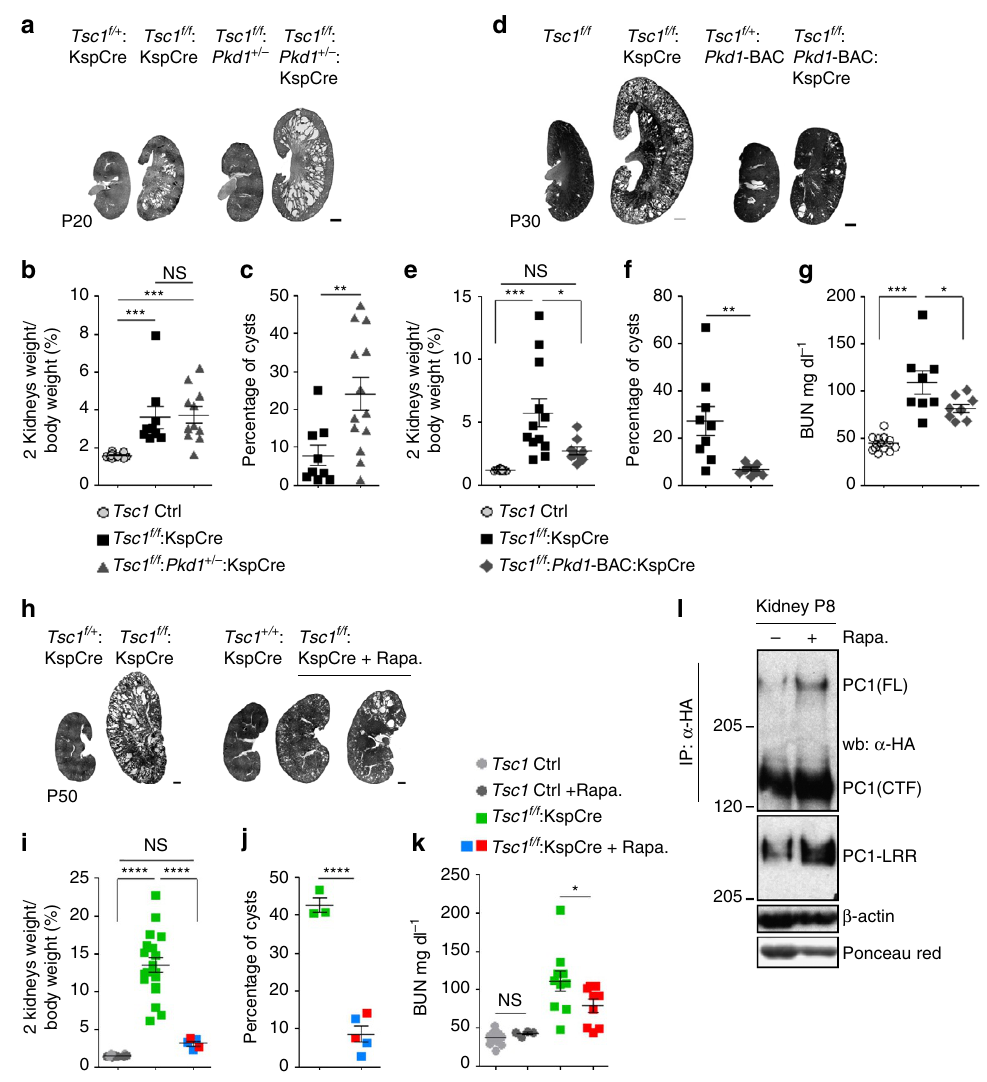
Figure 5 | Downregulation of PC-1 in Tsc1 mutant kidneys contributes to cyst formation. ( a ) H&E staining of kidney sections from Tsc1 f/f :KspCre , Tsc1 f/ f :Pkd1 þ /- :KspCre and control mice at P20. Scale bar, 1,000 m m. ( b ) Graph shows the two kidneys over body weight ratio at P20 in Tsc1 f/f :KspCre ( n ¼ 9) and Tsc1 f/f :Pkd1 þ /- :KspCre ( n ¼ 13) compared with controls ( n ¼ 18). Data are shown as mean ± s.e.m. ( c ) Graph shows the cystic index in Tsc1 f/f :KspCre ( n ¼ 9) compared to Tsc1 f/f : KspCre:Pkd1 þ / (cid:2) ( n ¼ 13) mice at P20. Data are shown as mean ± s.e.m. ( d ) H&E staining performed in P30 kidney sections from controls, Tsc1 f/f :KspCre and Tsc1 f/f : KspCre:Pkd1 -BAC transgenic mice ( n ¼ 5). Scale bar, 1,000 m m. ( e ) Graph shows the two kidneys over body weight ratio in controls ( n ¼ 15), Tsc1 f/f :KspCre ( n ¼ 12) and Tsc1 f/f :Pkd1 -BAC :KspCre ( n ¼ 9) transgenic mice. Data are shown as mean ± s.e.m. ( f ) Cystic index analysis in kidneys at P30 of Tsc1 f/f : KspCre:Pkd1 -BAC transgenic mice ( n ¼ 9) compared to Tsc1 f/f :KspCre ( n ¼ 9). Data are shown as mean ± s.e.m. ( g ) Graph shows analysis of BUN at P30 in mice from figure ( e ) Data are shown as mean ± s.e.m. ( h ) H&E staining on kidney sections from untreated or rapamycin (1mgkg (cid:2) 1 ) treated Tsc1 f/f : KspCre mice at P50. In green are shown the untreated Tsc1 f/f :KspCre mice. Scale bar, 1,000 m m. ( i ) Graph shows the two kidneys weight over body weight ratio at P50 in controls ( n ¼ 12) and Tsc1 f/f :KspCre mice untreated ( n ¼ 20) and after rapamycin treatment ( n ¼ 5). ( j ) Graph shows the cystic index of one of two kidneys derived from mice treated in ( h ). Data are shown as mean ± s.e.m. ( k ) Graph shows analysis of BUN at P50 in controls and Tsc1 f/f :KspCre untreated (control n ¼ 19, cystic n ¼ 10) or treated with rapamycin (control n ¼ 4, cystic n ¼ 9). Data are shown as mean ± s.e.m. ( l ) Immunoprecipitation of endogenous HA-PC-1 from P8 kidneys of Pkd1 HA/HA mice, treated or not with 1mgkg (cid:2) 1 rapamycin, followed by a western blot with anti-HA (FL, Full-length PC-1; CTF, C-terminal cleavage) or anti-LRR antibodies Data are representative of two independent experiments.